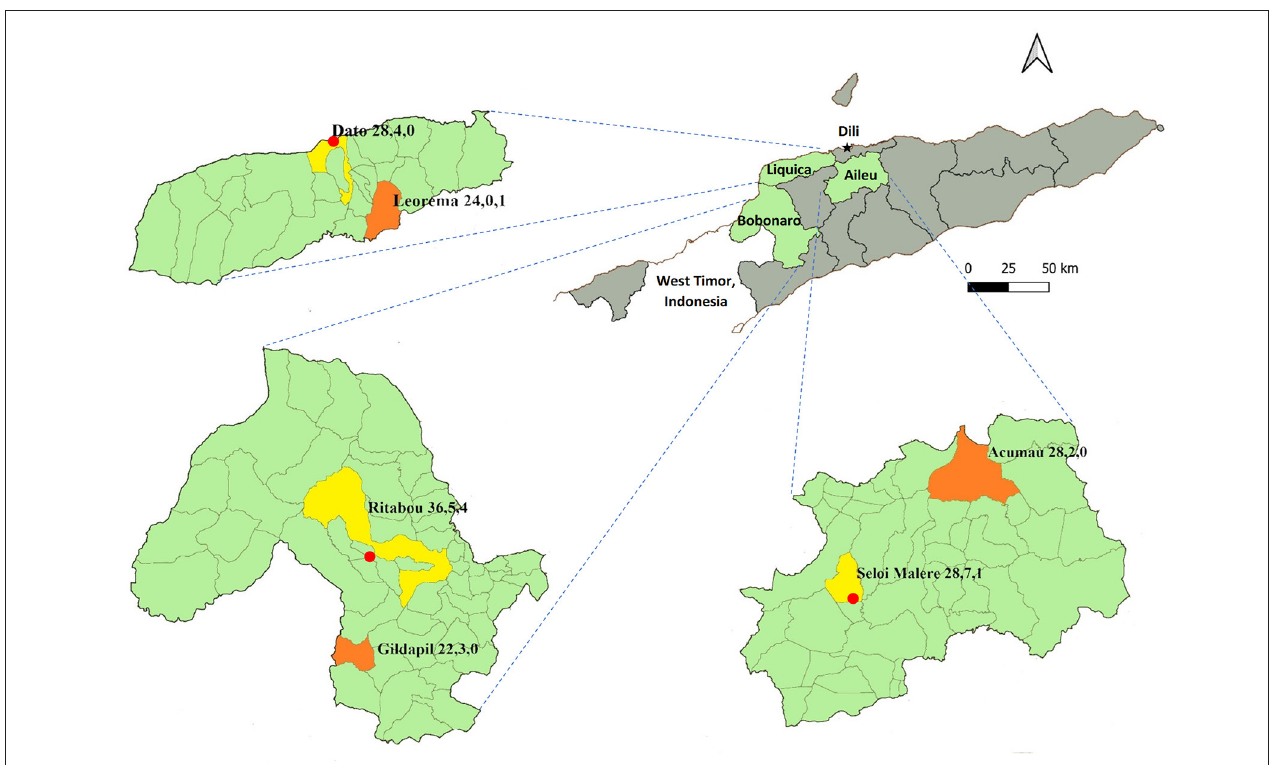
FIGURE 1 | Map of Timor-Leste showing the three target municipalities (Liquica, Bobonaro, Aileu) and selected urban (yellow) and rural (orange) sucos. The red circle represents the capital of each municipality. Numbers shown for each suco refer to the number of farmers interviewed, the number of farmers who reported knowing what antibiotics are, and the number of farmers who reported that antibiotics had been used in their pigs, respectively.